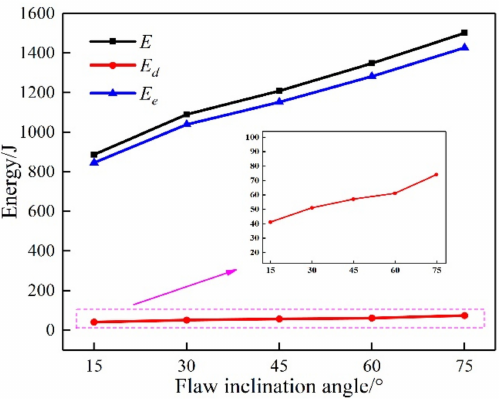
Figure 8. Energy variation of sample models with different flaw inclination angles under peak stress.